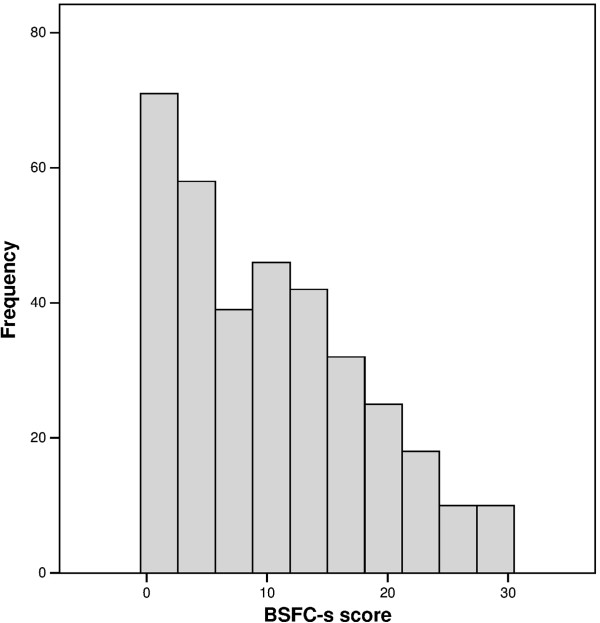
Distribution of the BSFC-s score. 25th percentile: 3. 50th percentile: 9. 75th percentile: 16.